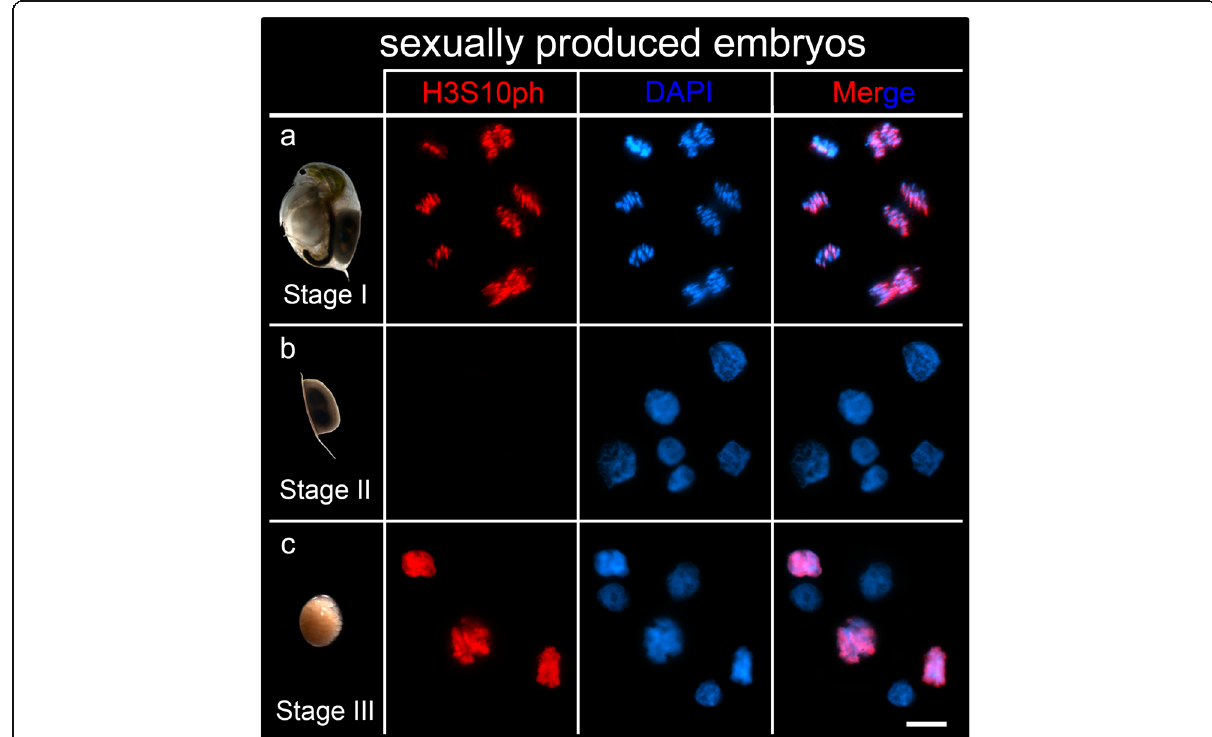
Fig. 2 Mitosis in sexually produced embryos. The phosphorylated histone H3S10ph identifies chromatin during metaphase and anaphase (red) which overlaps with chromatin stained with DAPI (blue). a Mitotic cells identified with H3S10ph are found in stage I embryos. Metaphases, anaphases and telophases are shown in the image. b The HS10ph signal is absent in stage II embryos. These images show several interphases and no dividing cells. c Dividing cells showing H3S10ph epigenetic marks are observed in stage III embryos that are resurrected from diapause. Late prophases and metaphases are visible in the image. Scale bars = 10 μ